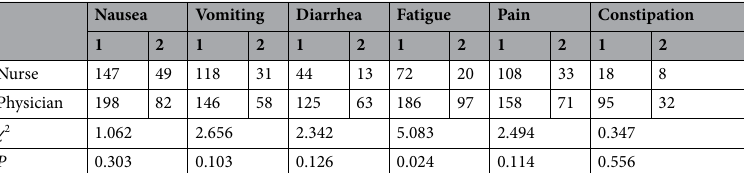
Table 3. Comparison of toxicity reported by nurses and